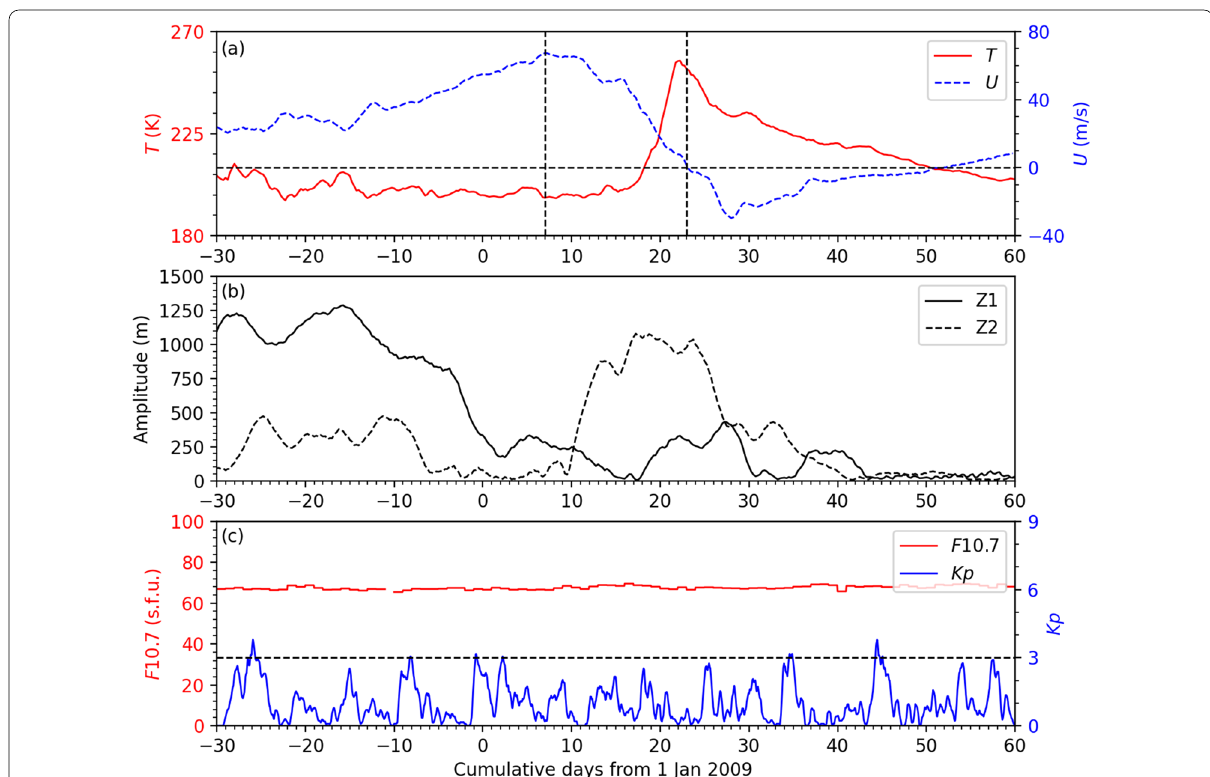
Fig. 2 The stratospheric polar temperature and wind, the planetary wave activity, and the solar and geomagnetic indices as a function of cumulative days from 1 January 2009. a T (red) is the temperature at 90°N, 10 hPa and U is the zonal mean zonal wind at 60°N, 10 hPa. The vertical dashed lines mark the initiation dates of the decrease and reversal of U . b Z1 and Z2 are the planetary-wave amplitudes of zonal wavenumber 1 and 2 components, respectively, calculated from the geopotential height at 60°N, 10 hPa. c The Kp (blue) and F10.7 (red)